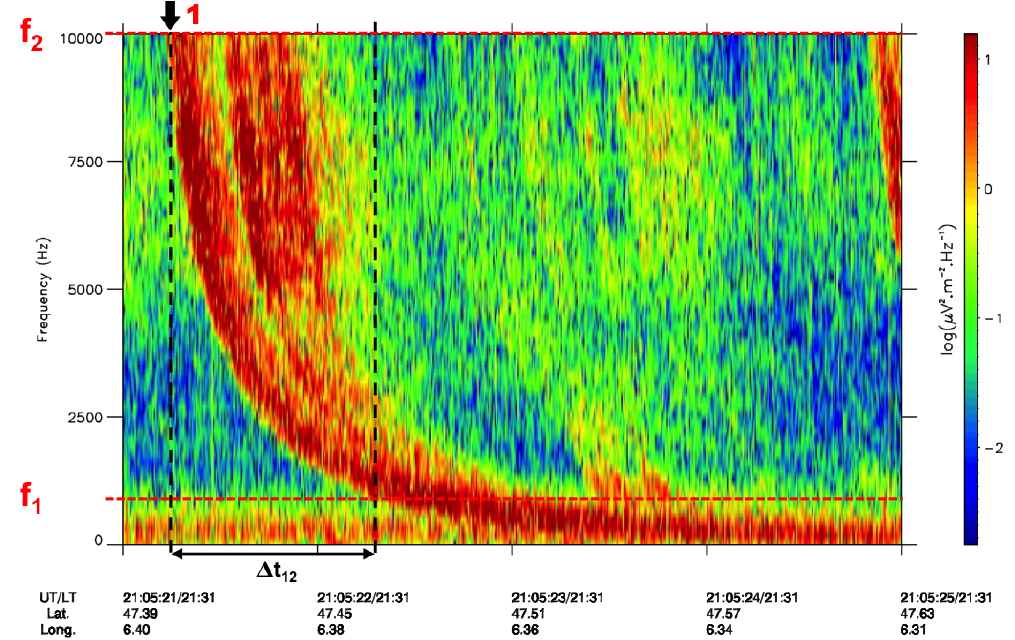
Figure 8. High-resolution ICE data VLF spectrogram up to 10kHz at the time of the three simultaneous lightning strokes and the associated whistler (1) in Fig. 7. The vertical and horizontal dashed lines correspond to the time and the frequency difference, respectively, used to compute the dispersion parameter D 0 of the whistler (see